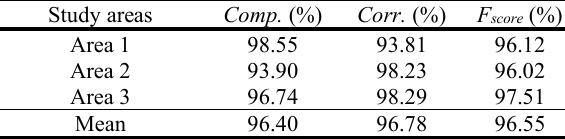
Table 2. Quality parameters estimated for areas 1, 2 and 3 using the proposed method for building detection.